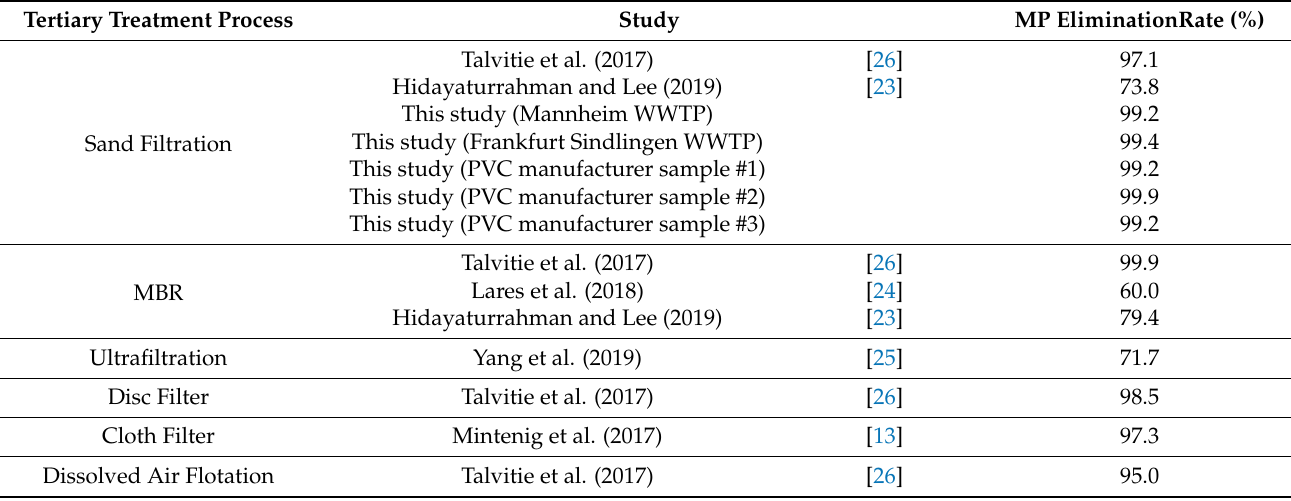
Table 5. Comparison of MP elimination of different tertiary treatment stages within various studies. Tertiary Treatment Process Study MP EliminationRate